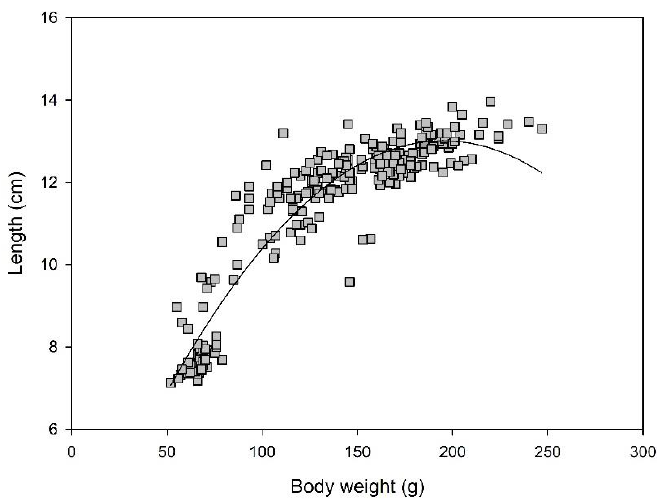
Figure 4. Exponential correlation between body weight ( x -axis) and length ( y -axis) of adult Xenopus laevis frogs ( n = 238, y = − 0.0003x 2 + 0.1132x + 1.9692; R 2 = 0.87). In females, there was a strong linear correlation between the triangular surface ( x -axis) and the body weight ( y -axis; y = 0.13x + 10.11, R 2 = 0.91; Figure 5). This correlation was weak in the male frogs (y = 0.10x + 4.83; R 2 = 0.31; Supplementary Figure S1), but the slopes of the regression lines did not differ significantly between the sexes ( p = 0.187).